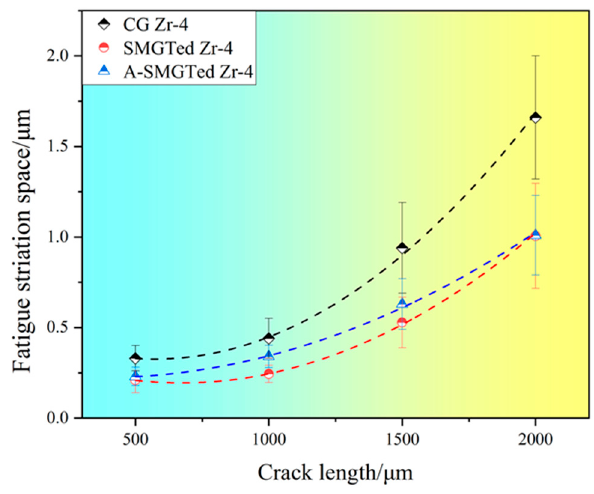
Figure 8. Fatigue striations space versus crack length curves.